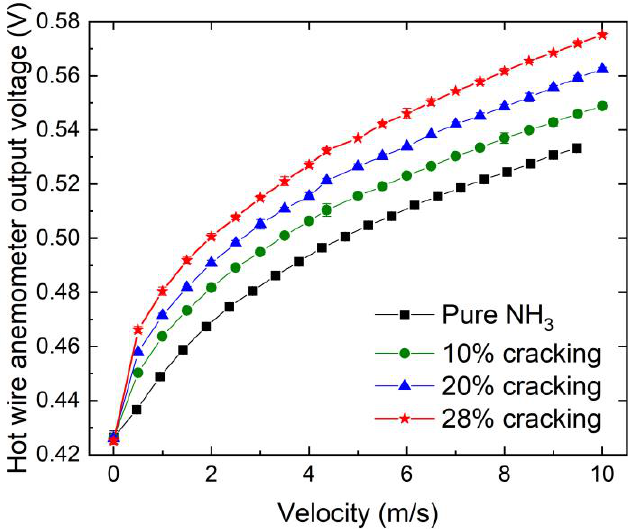
the calibration plots obtained for velocities up to 10 m/s. The overall uncertainty of the procedure and apparatus. In Figure 3, the error bars correspond to the maximal discrepancy between two measurements at the same condition.